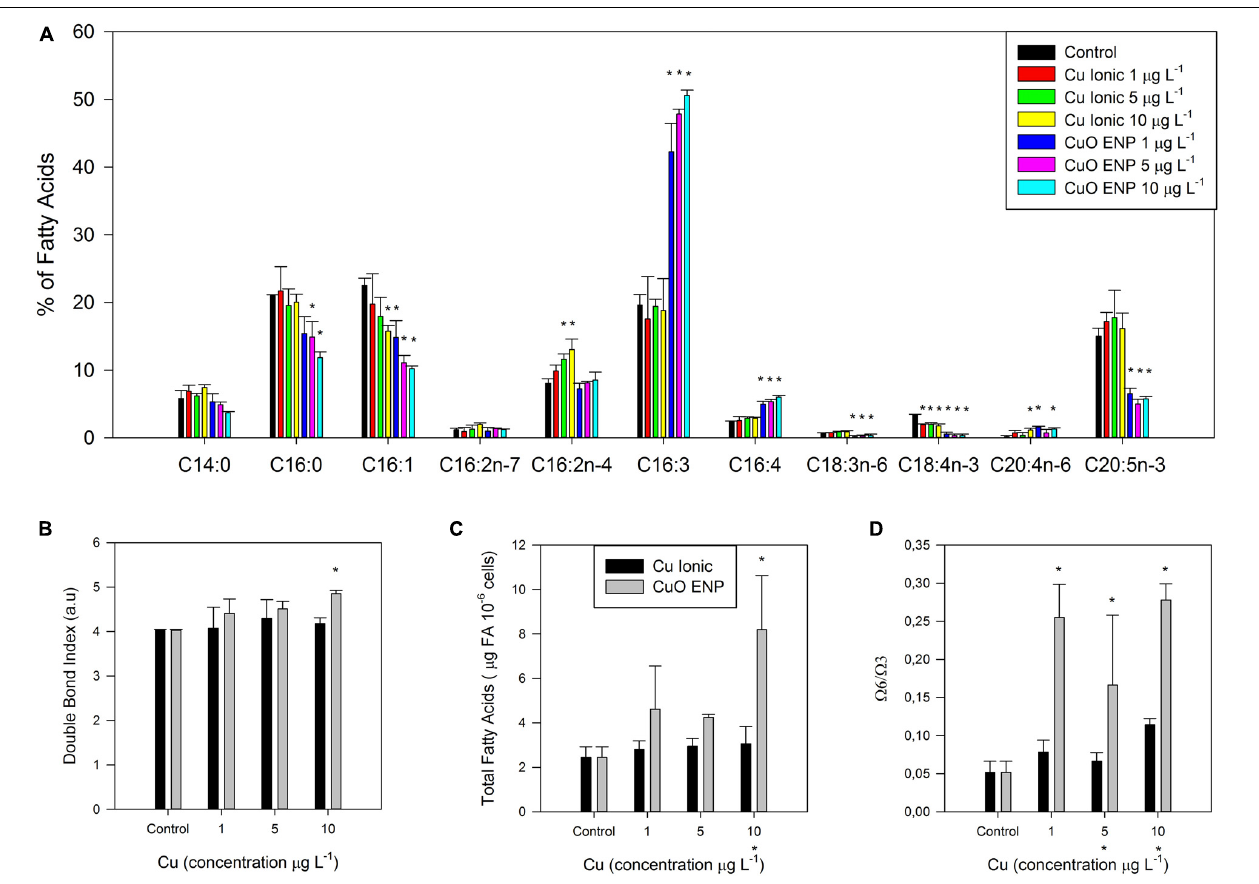
FIGURE 7 | (A) Fatty acid composition, (B) double-bond index, (C) fatty acid content ( µ g 10 - 6 cells), and (D) omega-6/omega-3 ratio in P. tricornutum , after 3 days of exposure to increasing ionic Cu (black bars) and CuO ENP (gray bars) concentrations (average ± standard deviation, N = 3, *above bars indicate significant differences compared with the control at p < 0.05, whilst *below x -axis indicate significant differences between ionic Cu and CuO ENP at the same